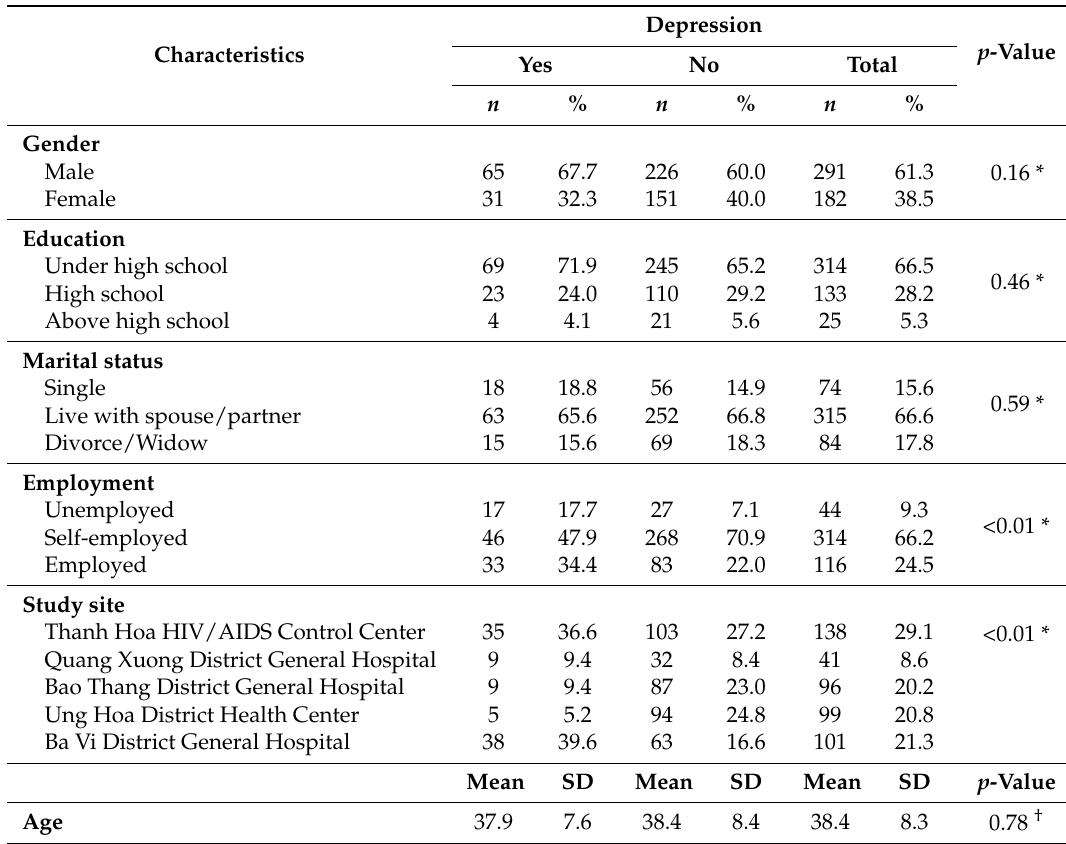
Table 1. Demographic characteristics of patients receiving antiretroviral treatment (ART) ( n = 482).